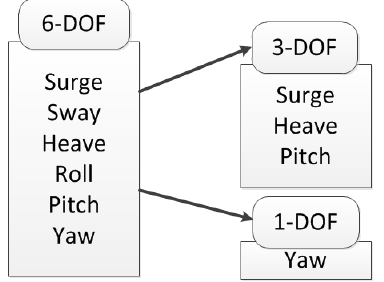
Figure 5. Modeling concept. DOF: degree of freedom.